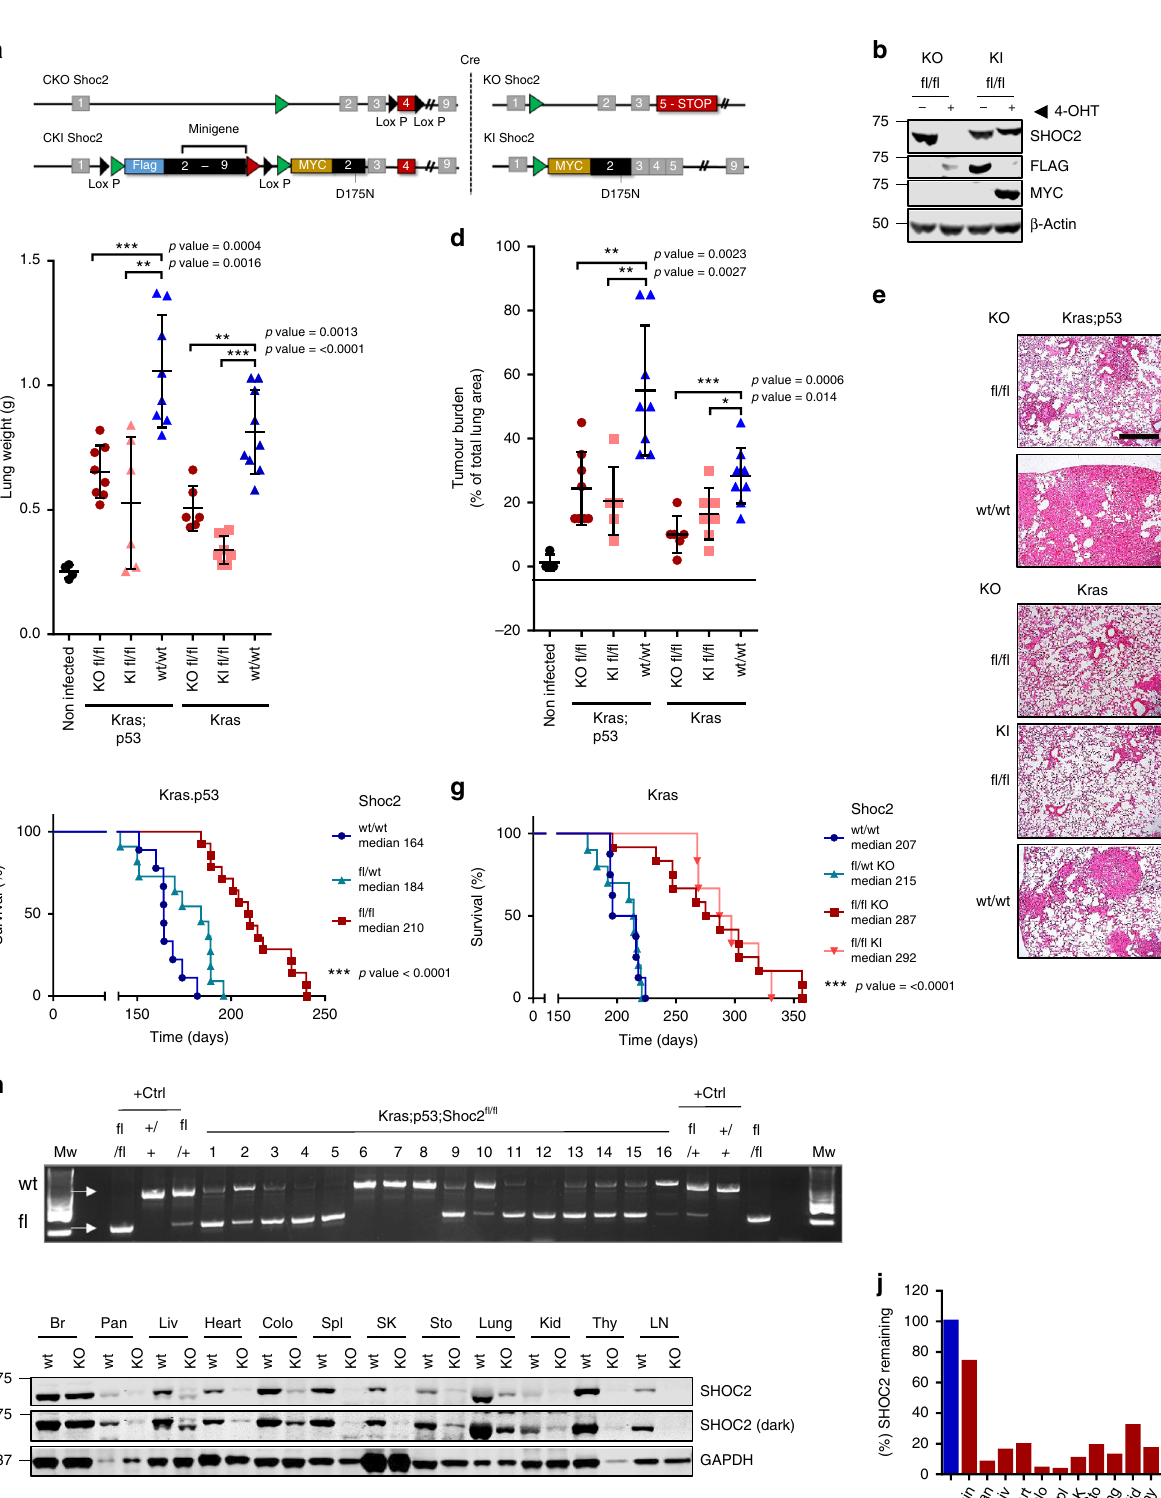
(Supplementary Table 1 ) . Serum-starved SHOC2 knock-out (KO)/Knock-down (KD) cells consistently had higher basal levels of phospho-S365 BRAF and showed impaired EGF-induced S365/S259 B/CRAF dephosphorylation and MEK and ERK phosphorylation. In contrast, RAS activation or S338 CRAF phosphorylation were unaffected by SHOC2 downregulation (Fig. 2a, Supplementary Fig. 1a, b). Furthermore, re-expression of